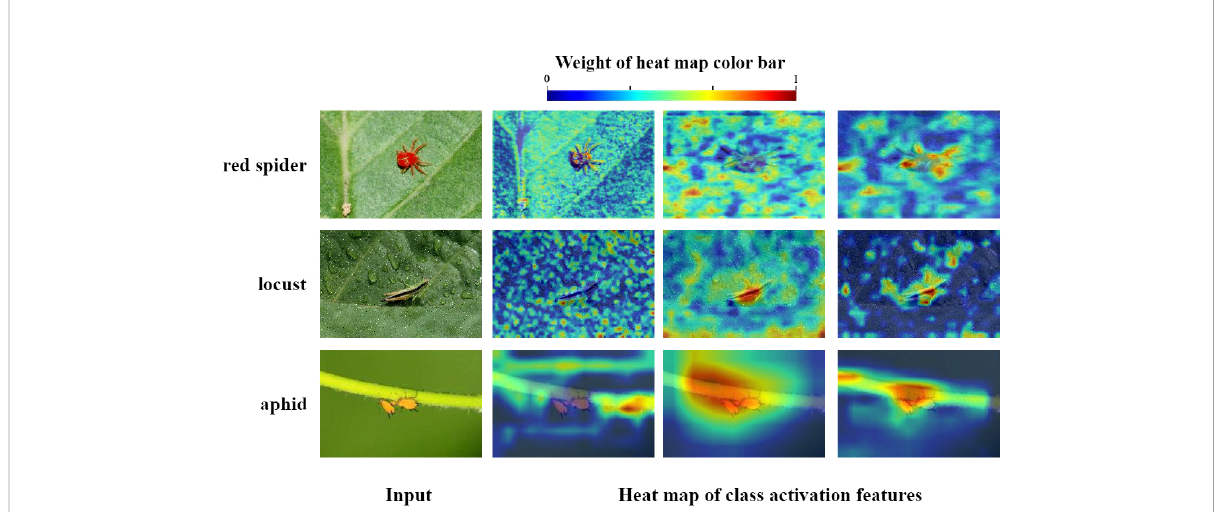
FIGURE 10 Heat map visualization with S-ResNet34 feature extraction module. The heat maps of class activation features in b are the output of the 2nd, 3rd, and 4th RSB modules (from left to right). Red pixels represent the area of concern of the model while the blue pixels represent the area of considered background.